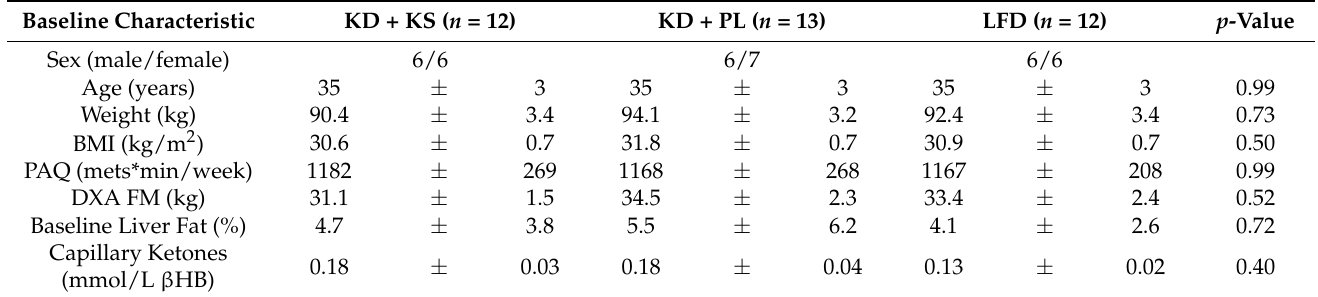
Table 1. Participant